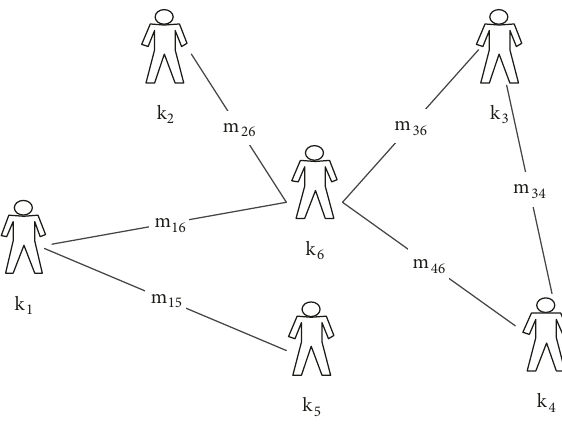
Figure 1: Social network of voting